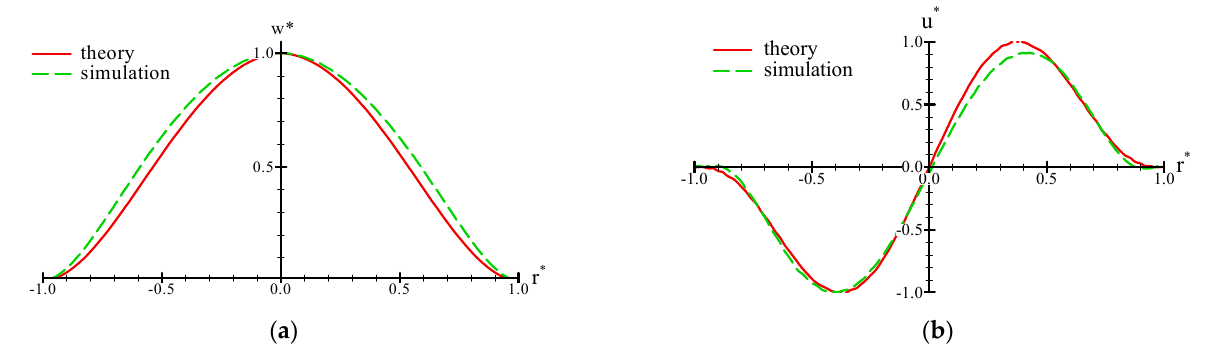
Figure 8. Comparisons of theoretical calculation and numerical simulation for the profiles of ( a ) w*(r*) and ( b ) u*(r*). Here, w* = w/w amx , u* = u/u max , and r* = r/a.